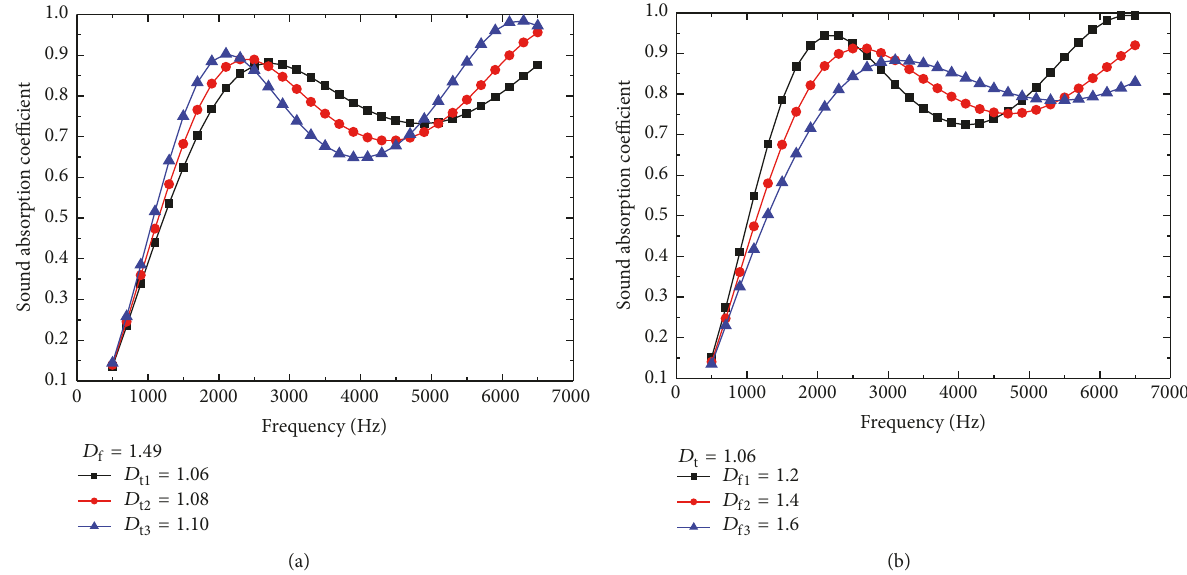
Figure 19: The Sound absorption coefficient versus the fractal dimensions. (a) 𝐷 f = 1.49 and 𝐷 t = 1.06 , 1.08 , and 1.10 , respectively; (b) 𝐷 = 1.06 and 𝐷 = 1.2 , 1.4, and 1.6, t f